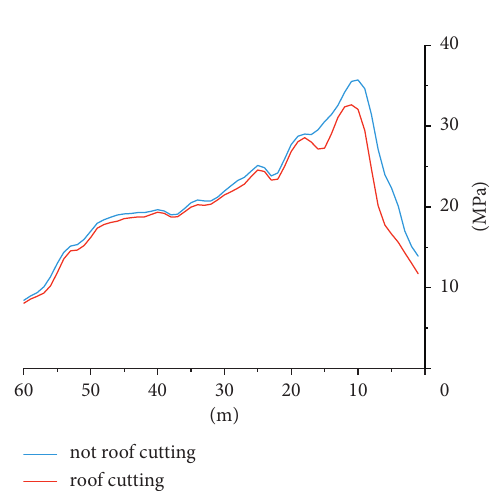
Figure 10: Stress curve of the surrounding